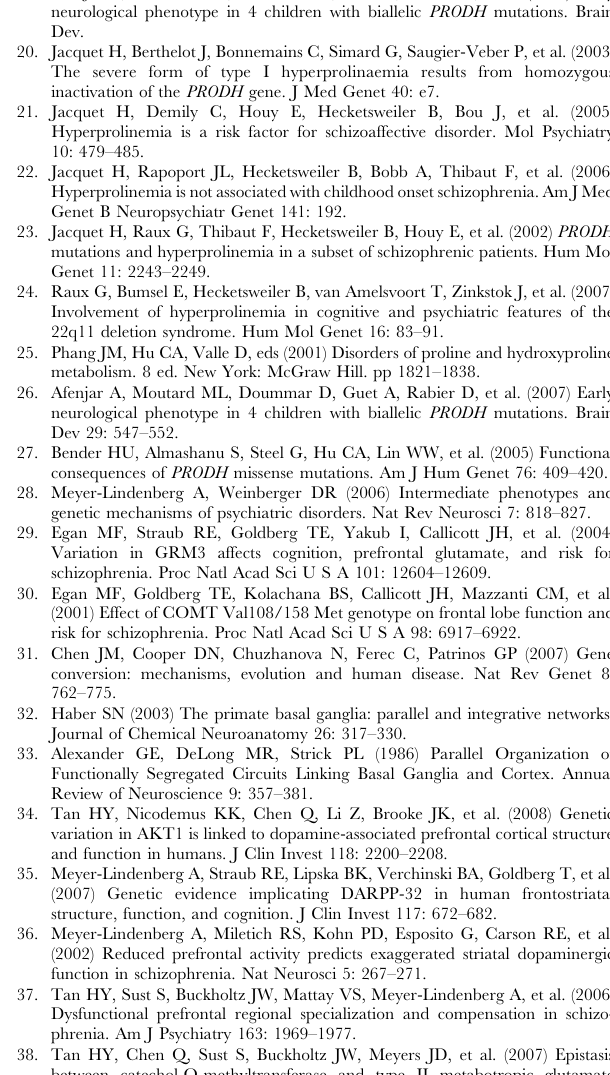
Table S2 Nback working memory reference . risk haplotypes.